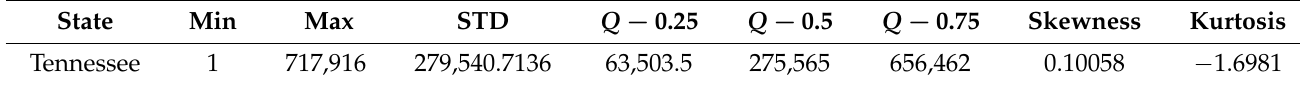
Table 1. Statistical Summary of COVID-19